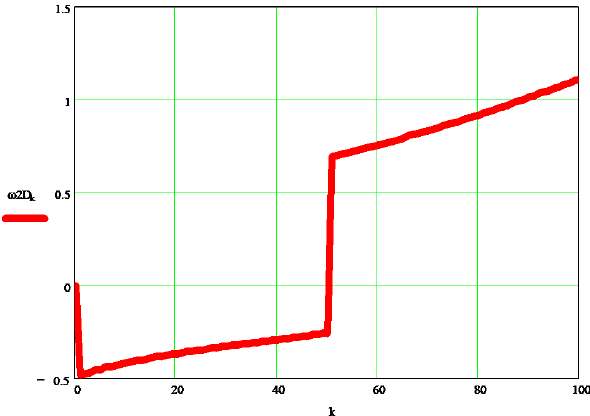
Figure 6. Variation of the dynamic angular velocity 2, depending on the independent parameter k .